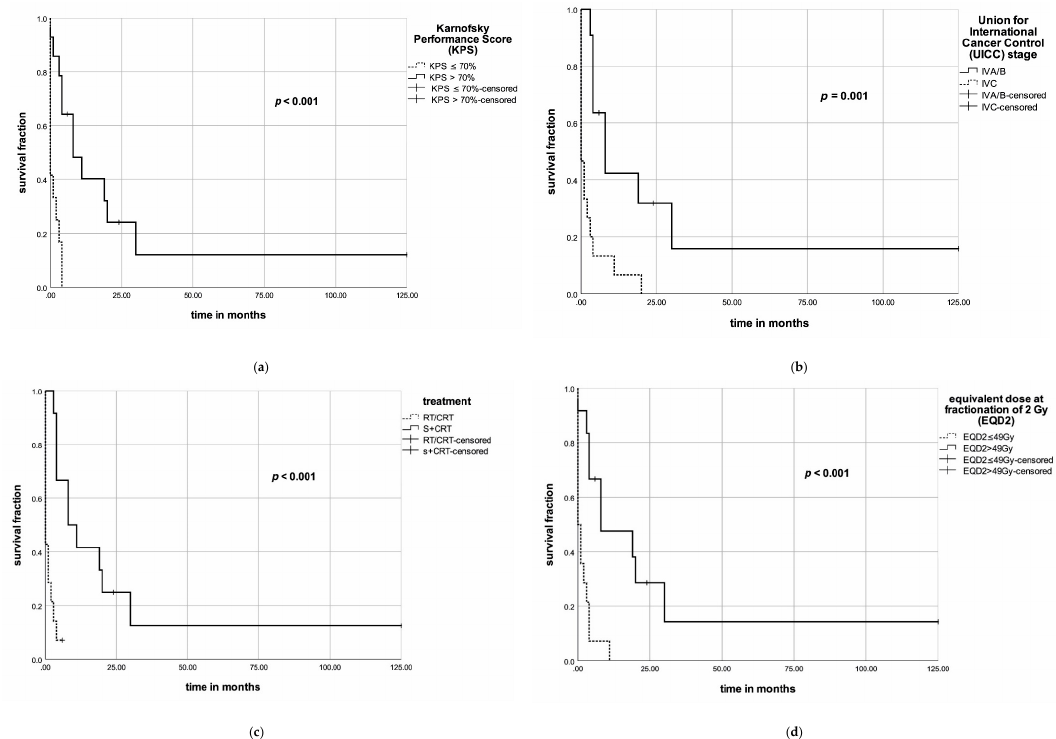
Figure 3. ( a ) Kaplan–Meier diagram for the Karnofsky performance status (KPS) and overall survival; ( b ) Kaplan–Meier diagram for the UICC stage and overall survival; ( c ) Kaplan–Meier diagram for treatment approaches and overall survival; ( d ) Kaplan–Meier diagram for EDQ2 levels and overall survival.